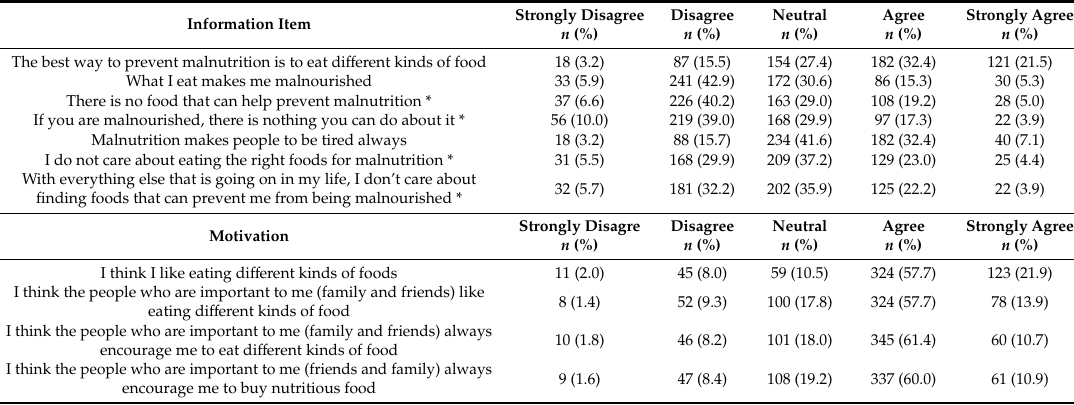
Table 5. Information of on